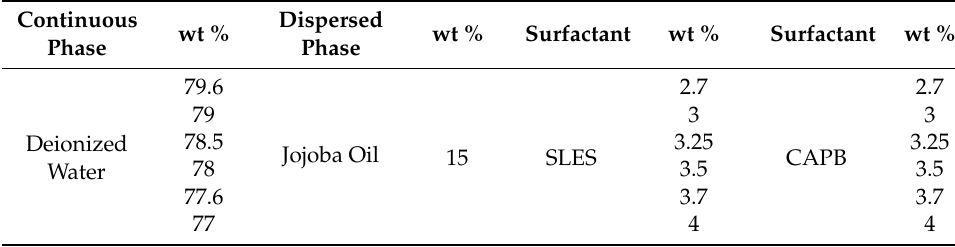
Table 1. Jojoba Oil Emulsion Formulations.